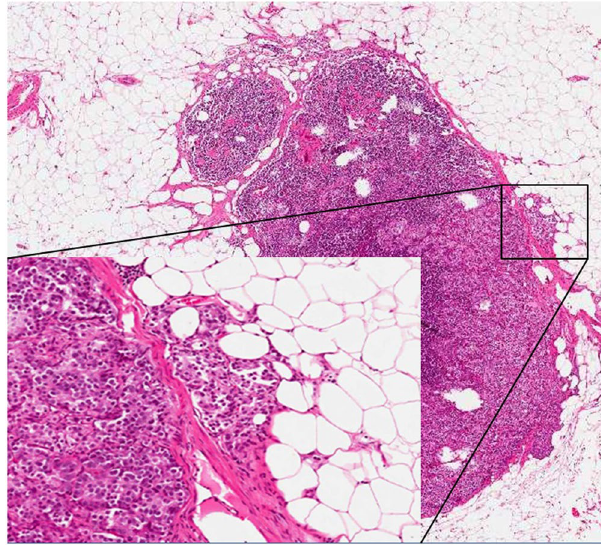
Figure 1. A classical example of extra-nodal extension of nodal metastasis of prostate cancer is here shown. Note the rupture of nodal capsule and the invasion by the metastatic cells of the peri-nodal adipose tissue (original magnification: 4 × metastatic lymph node, 10 × detail of the metastasis in the